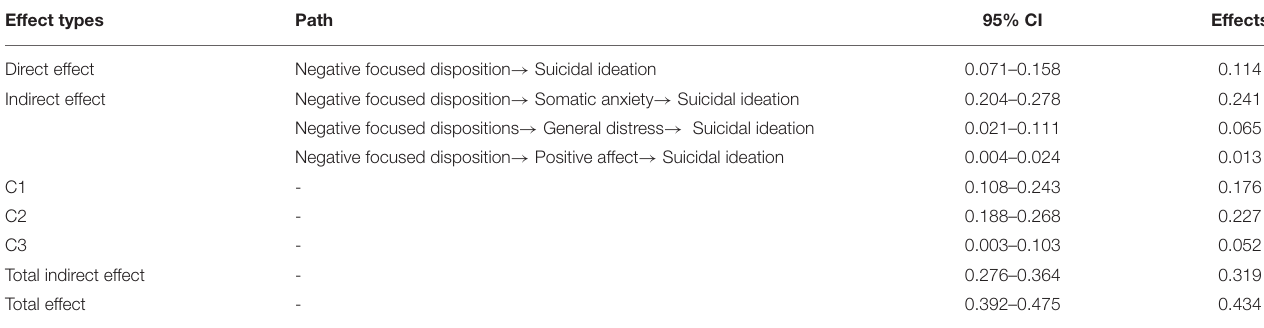
TABLE 4 | Mediating effects of somatic anxiety, general distress and positive affect between negative focused disposition and suicidal ideation. Effect